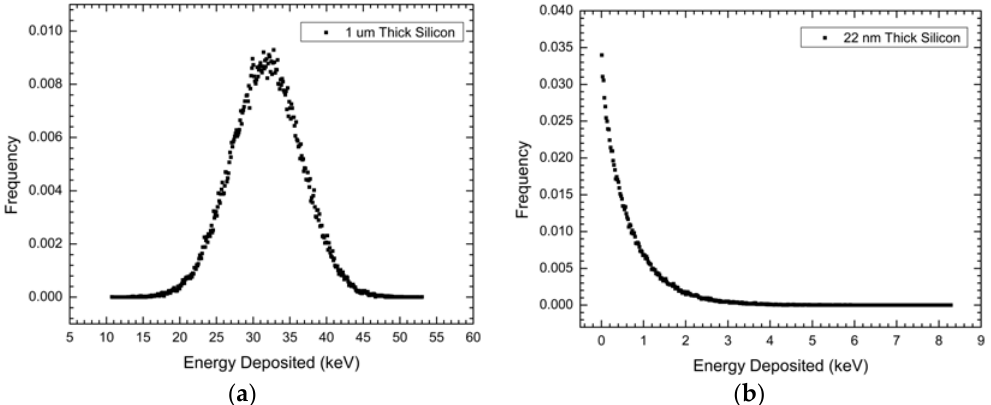
Figure 7. ( a ) Energy loss spectrum for ten thousand protons penetrating through the 1 µm thick silicon detector; ( b ) Energy loss spectrum for ten thousand protons penetrating through the 22 nm thick silicon detector.